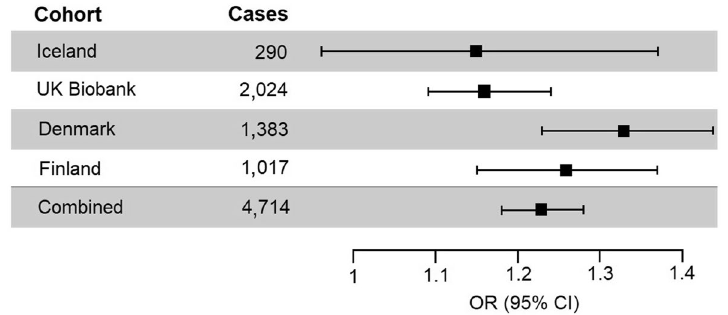
Figure 2. Forest plot of the observed risk of Bell’s palsy for individuals carrying rs9357446-A in each study sample. The number of Bell’s palsy cases in each sample is shown in the second column.